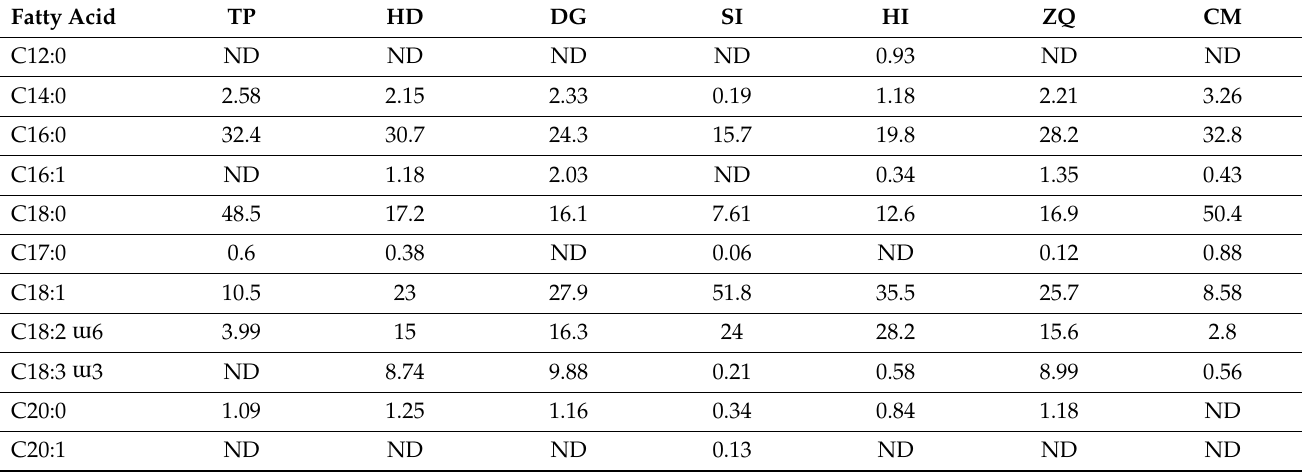
Table 2. Fatty acid compositions (% of total fat) of the United Arab Emirates wild